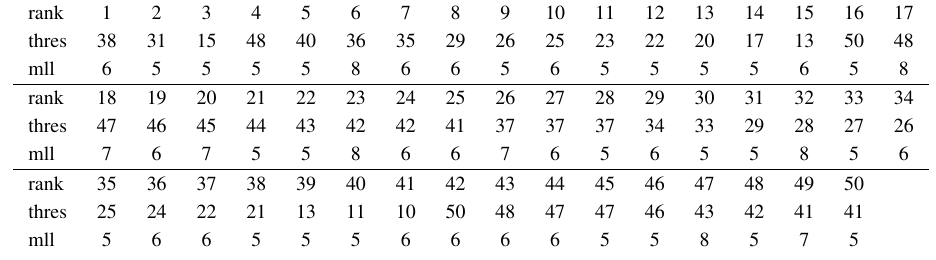
Table A1. 50 Hough input parameter combinations (threshold value (thres) and minimal line length (mll)) ranked according to the C-score for a test period covering the whole Arctic and lasting from February to April